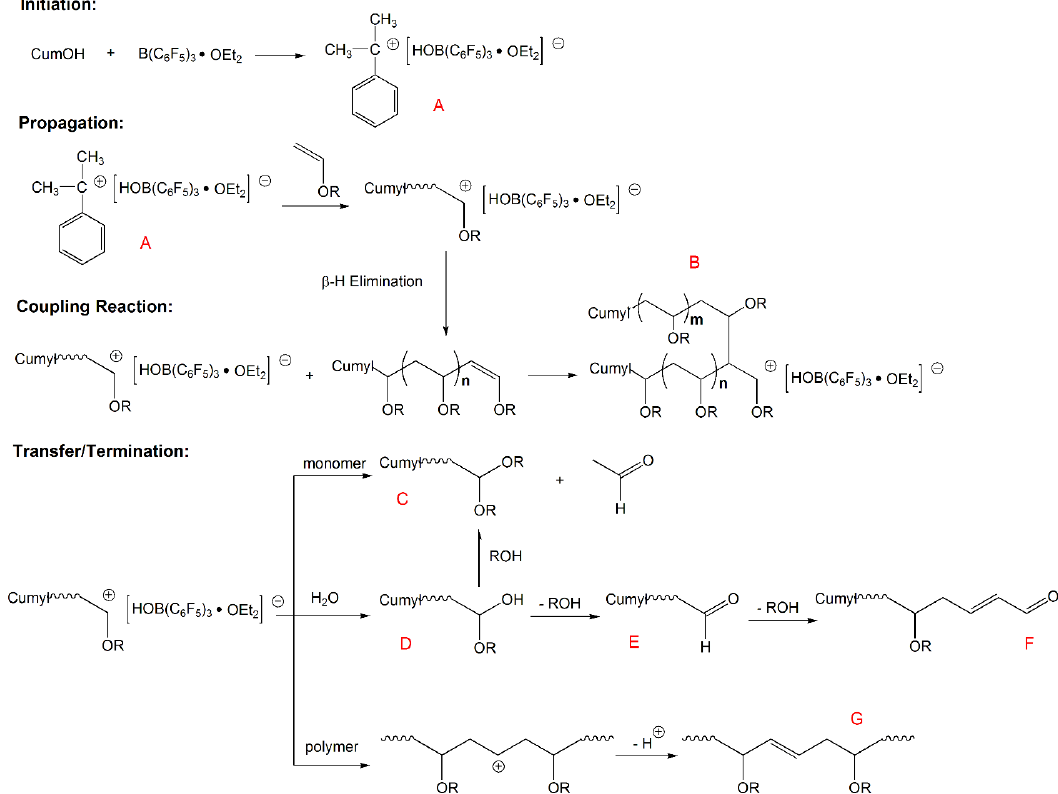
Scheme 1. Proposed mechanism for the aqueous cationic polymerization of vinyl ethers using CumOH/B(C 6 F 5 ) 3 /Et 2